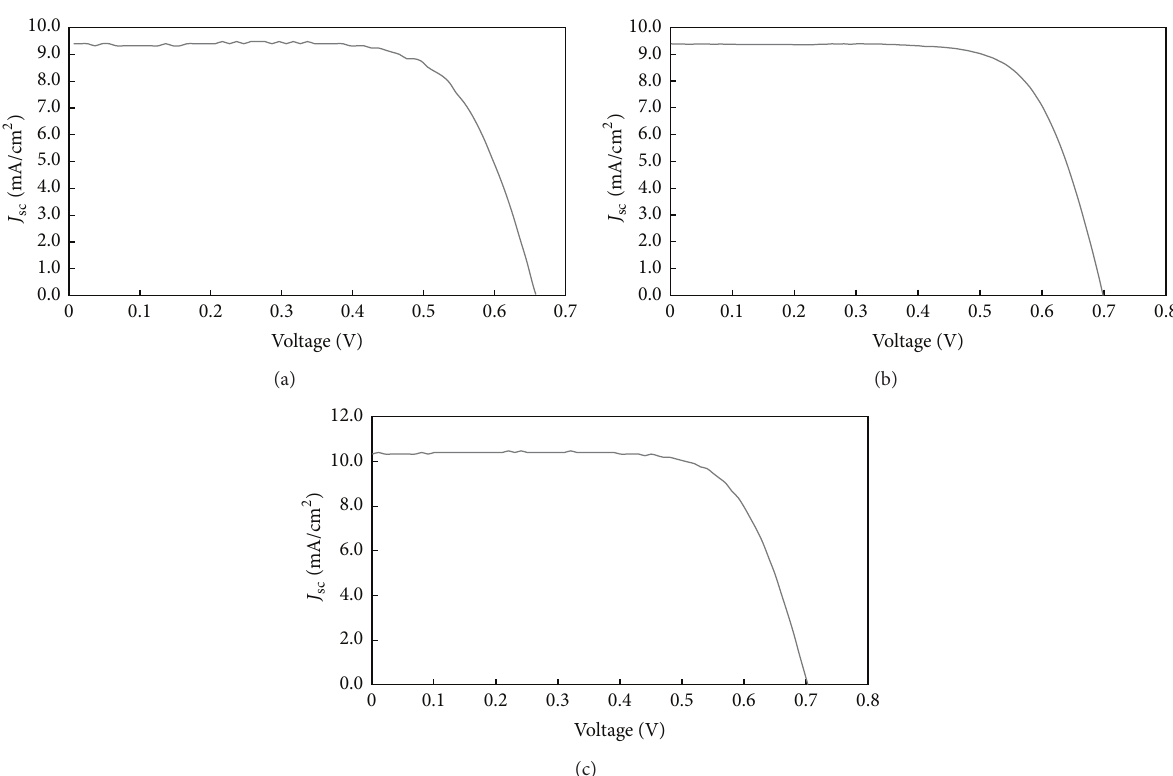
of the photoelectrode solar cell is strongly dependent on the annealing temperature and concentration of added